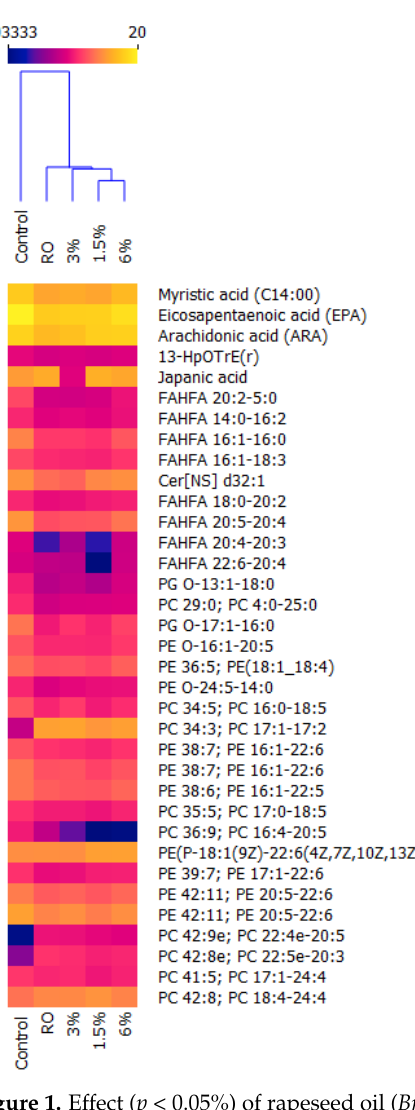
Figure 1. Effect ( p < 0.05%) of rapeseed oil ( Brassica napus ) and cochayuyo ( Durvillaea antarctica ) meal on the lipidome of juvenile rainbow trout ( Oncorhynchus mykiss ) muscle analyzed with LC-MS/MS. RO: rapeseed oil; 1.5%: 1.5% cochayuyo meal; 3%: 3% cochayuyo meal; 6%: 6% cochayuyo meal. Furthermore, Stearoyl-CoA desaturase (SCD) synthesizes oleate necessary for triglycerides and other lipids’ biosynthesis. It plays a critical role in transforming saturated fatty acids into unsaturated fatty acids by inducing the first double bond between the C9 and C10 from palmitic acid to palmitoleic acid and stearic acid to oleic acid. The Elongases of very long chain fatty acids (ELOV) are some of the major enzymes in the pathways for the elongation of C18 PUFAs to C20/22 unsaturated fatty acids [27].